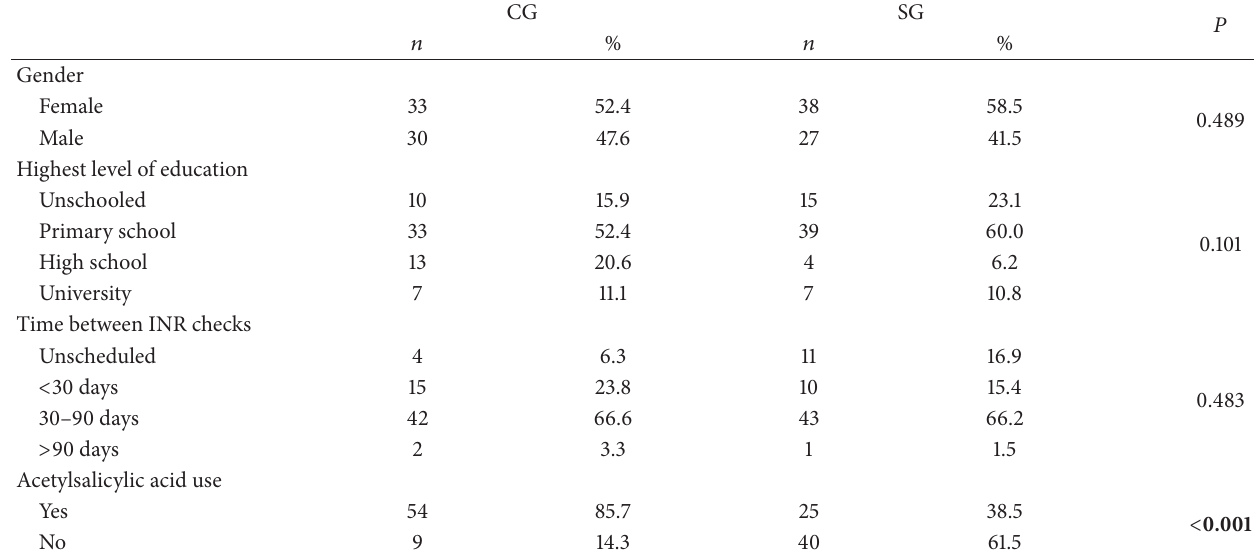
Table 1: Demographic data (age, gender, and education level), concomitant use of acetylsalicylic acid, and INR sampling frequency in